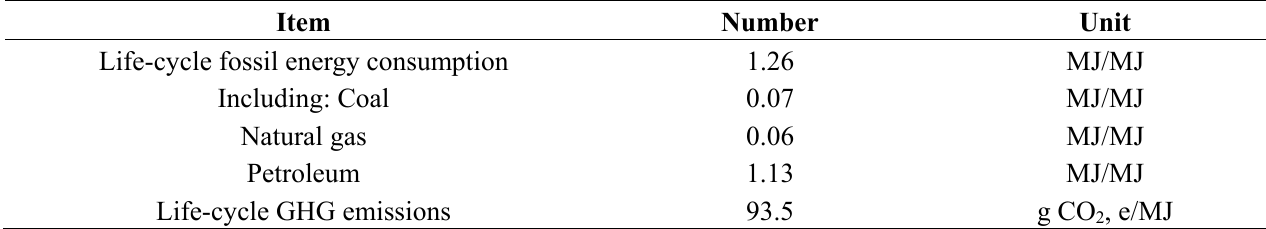
Table 1. Life-cycle energy consumption and GHG emissions of the petrochemical jet fuel pathway in China [36].